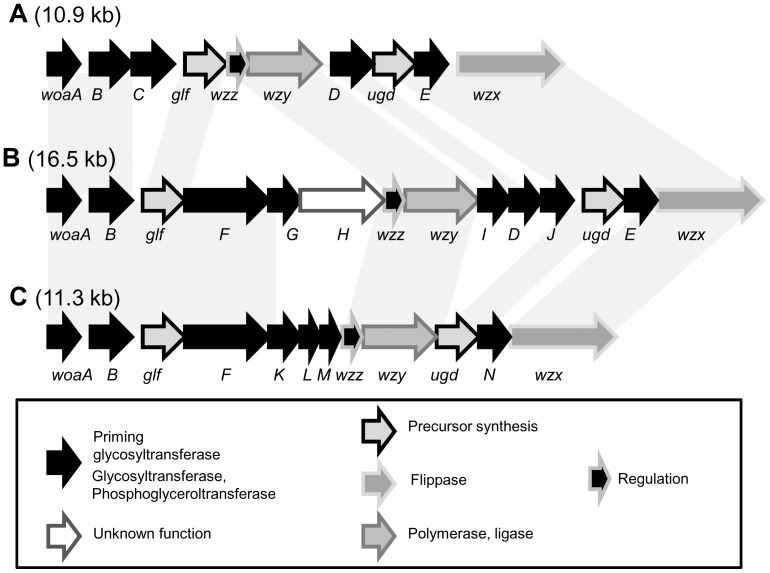
The three models of cluster eps1.The arrows filling indicate the putative function of the encoded proteins. The amino acid sequence similarities between the models are shown. Model A: reference strain
O. oeni
 PSU-1, other strains: BAA1163, B418, C23, C28, 0501, 0502, 8417, 9304, 9805, 9803, S12, S13, S14. Model B: reference strain
O. oeni
 B429, other strains: B202, B304, B318, B553, B568, B576, B10, 1491, L18_3, L40_4, L65_2, 9517, 0608, S161, L26_1, CiNe, 277, 450, S28, 0607, C52, S11, S15, S19, S22, S23, S25. Model C, reference strain
O. oeni
 B422, other strains B129, B419, B548, 436a, VF, 0205, B16.